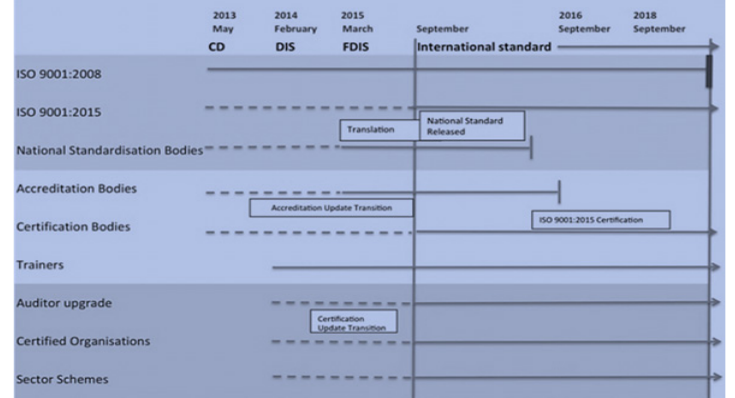
Figure 1 – Official transition from ISO 9001: 2008 standard to ISO 9001: 2015 Рис . 1 – Официальный переход с ISO 9001: 2008 стандарта на ISO 9001: 2015 Слика 1 – Прописани прелаз са стандарда ISO 9001:2008 на ISO